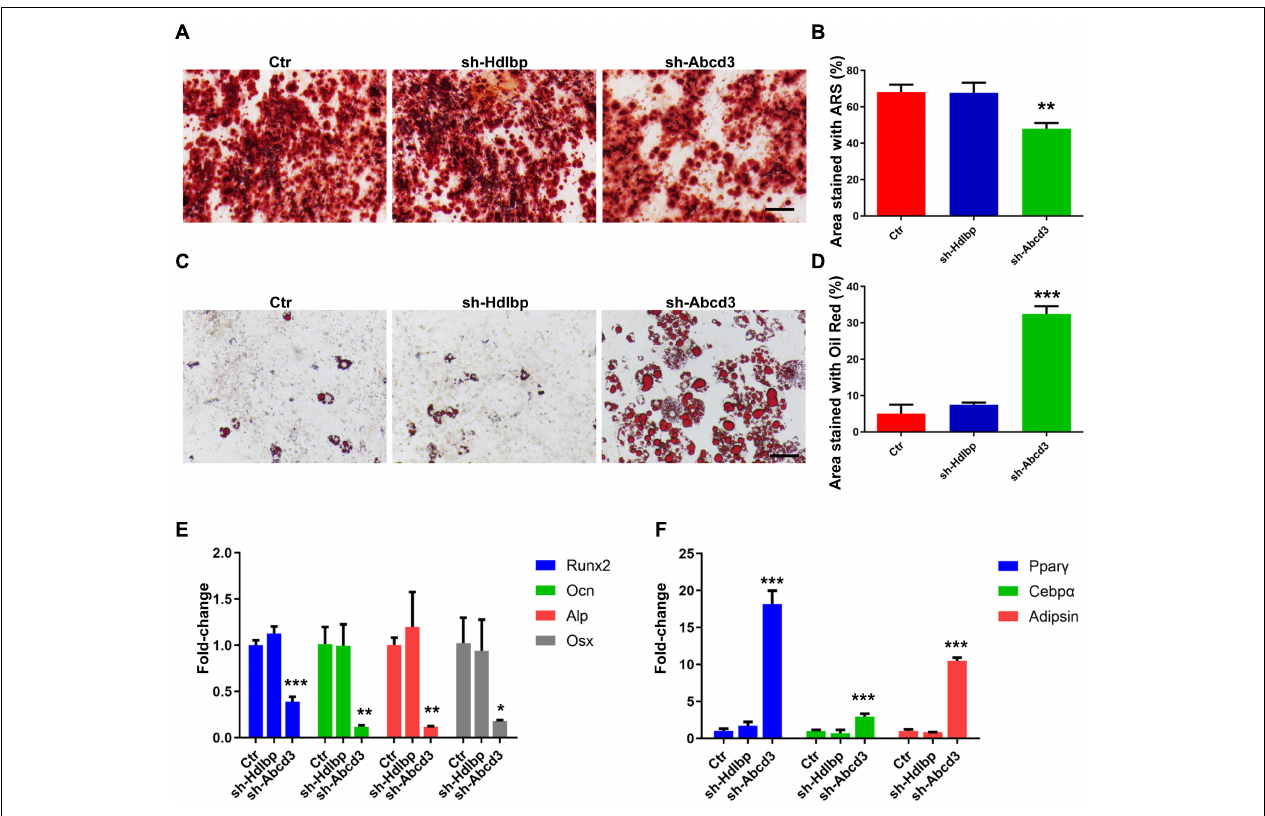
FIGURE 5 | The effects of HDLBP and ABCD3 on osteoblast and adipocyte differentiation in BM-MSCs. (A) Alizarin Red S dye solution was used to stain differentiated osteoblasts after HDLBP or ABCD3 suppression. (B) Quantification of the Alizarin Red S-stained areas in (A) , n = 3. (C) Oil Red O dye solution was used to stain differentiated adipocytes after HDLBP or ABCD3 inhibition. (D) Quantification of the Oil Red O-stained areas in (C) , n = 3. (E) The mRNA levels of facilitating factors involved in osteogenic differentiation were detected by QRT-PCR after HDLBP or ABCD3 inhibition, n = 3. (F) The mRNA levels of effective molecules regulating adipocyte differentiation were detected by QRT-PCR after HDLBP or ABCD3 inhibition, n = 3. Scale bar, 100 µ m, * p < 0.05; ** p < 0.01; *** p < 0.001, one-way